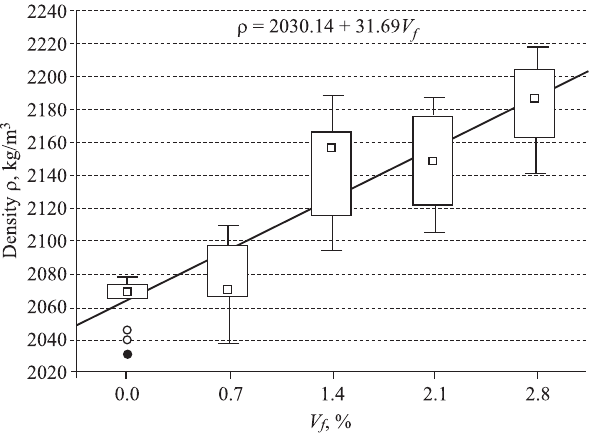
Fig. 3. Workability of SFRCC tested according to the VeBe procedure